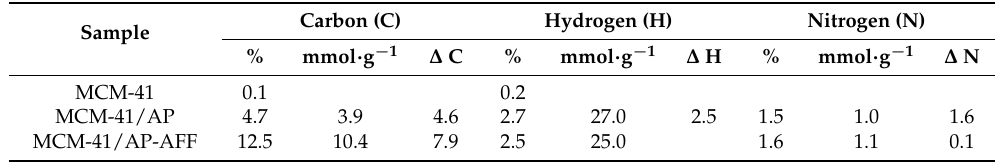
Table 4. Percentages of chemical elements carbon, hydrogen, and nitrogen in MCM-41, MCM-41/AP, and MCM-41/AP-FFA, given by elemental analysis.